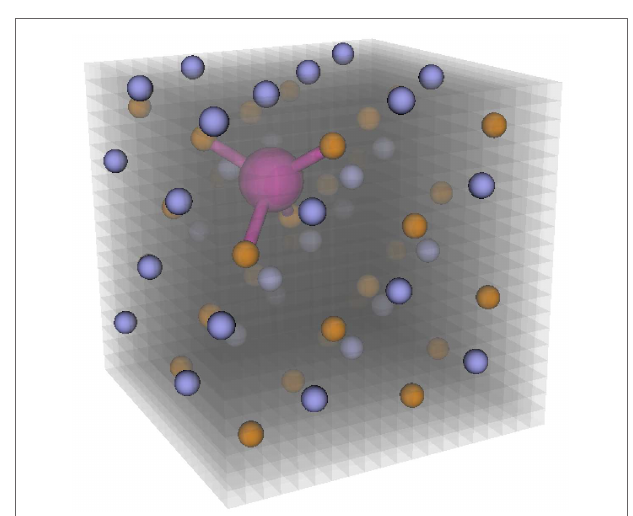
FIGURE 9 | The Interstitialcy Finding Tool (InFiT) performs structure-motif recognition on a regular grid in the unit cell.